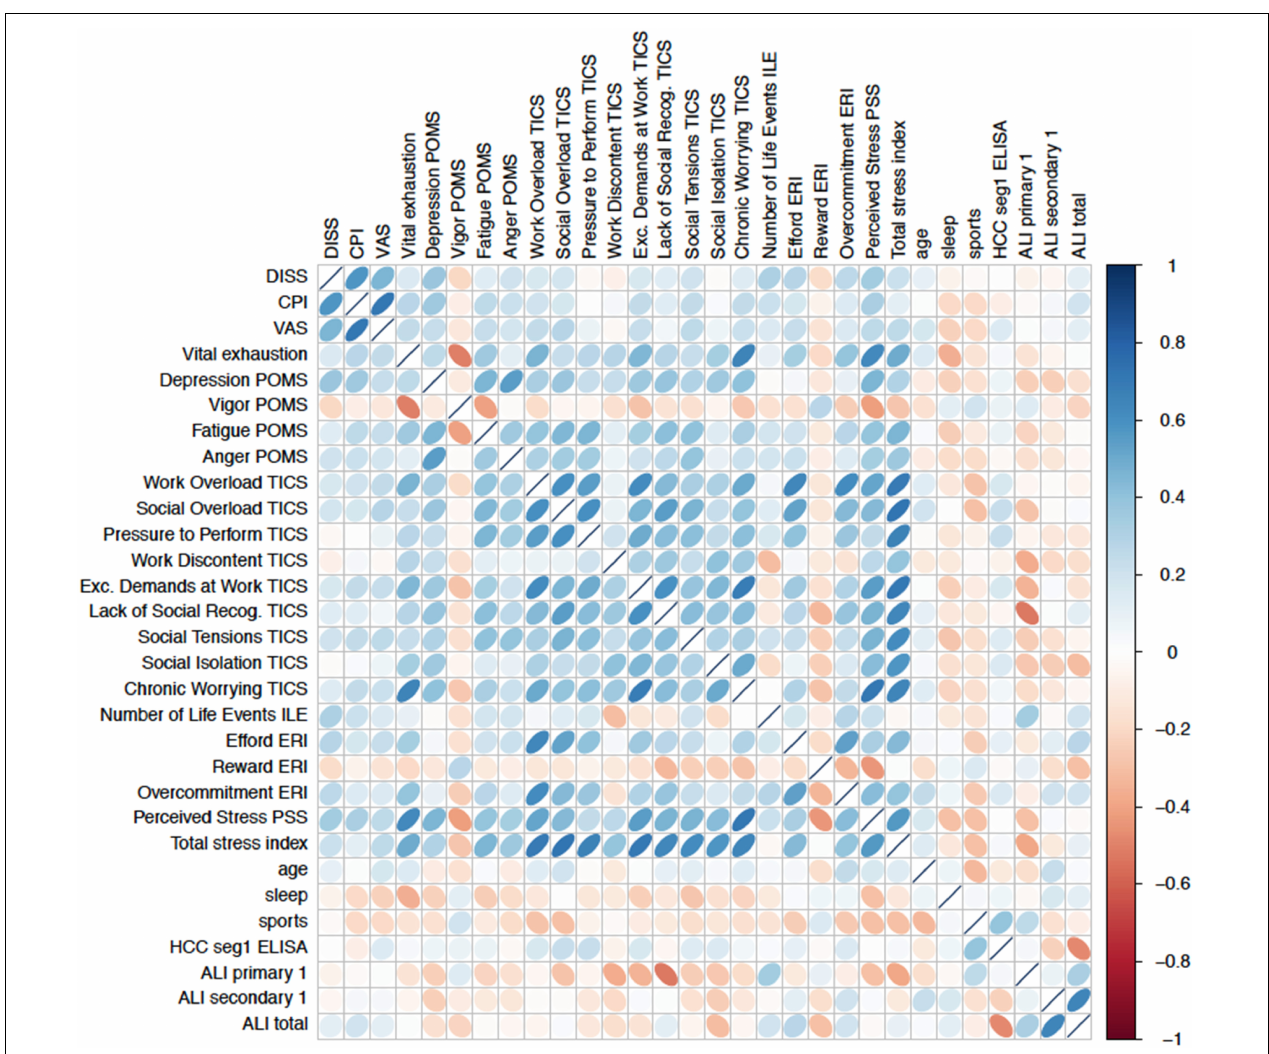
FIGURE 3 | Correlation matrix of baseline measures demonstrate intercorrelations between psychometric stress scales, lifestyle factors (sleep, age, and physical activity) and the outcome criteria. Intercorrelations limit the significance of prediction methods such as linear multiple regressions models in identifying best predictors.